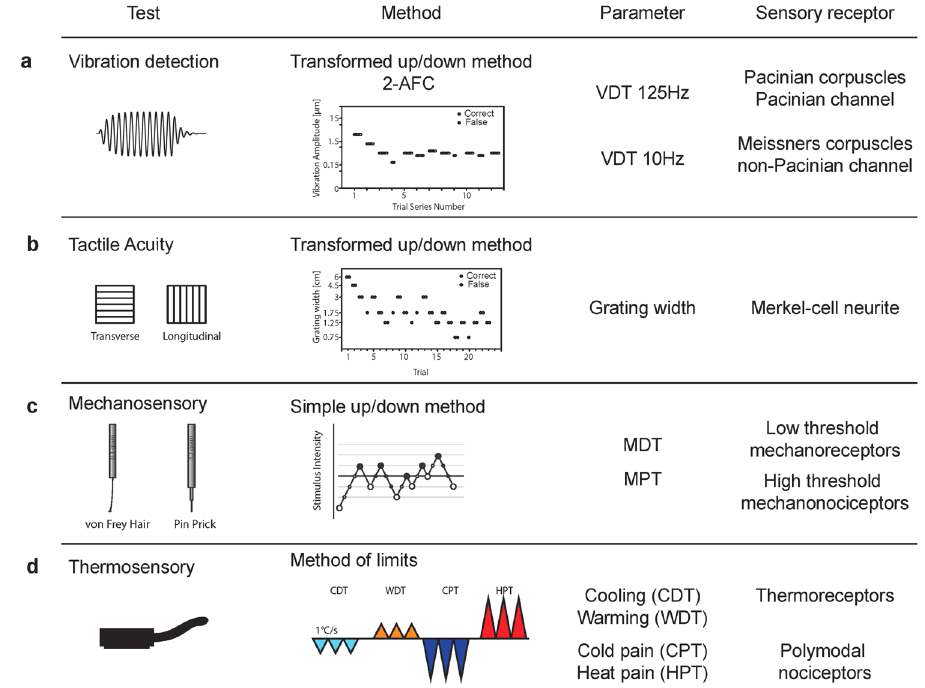
Figure 1. Overview of the sensory testing battery employed to generate the sensory profile for each tested subject. VDT, vibration detection threshold; MDT, mechanical detection threshold; MPT, mechanical pain threshold; CDT, cold detection threshold; WDT, warm detection threshold; CPT, cold pain threshold; HPT, heat pain threshold, 2-AFC; 2 alternative forced